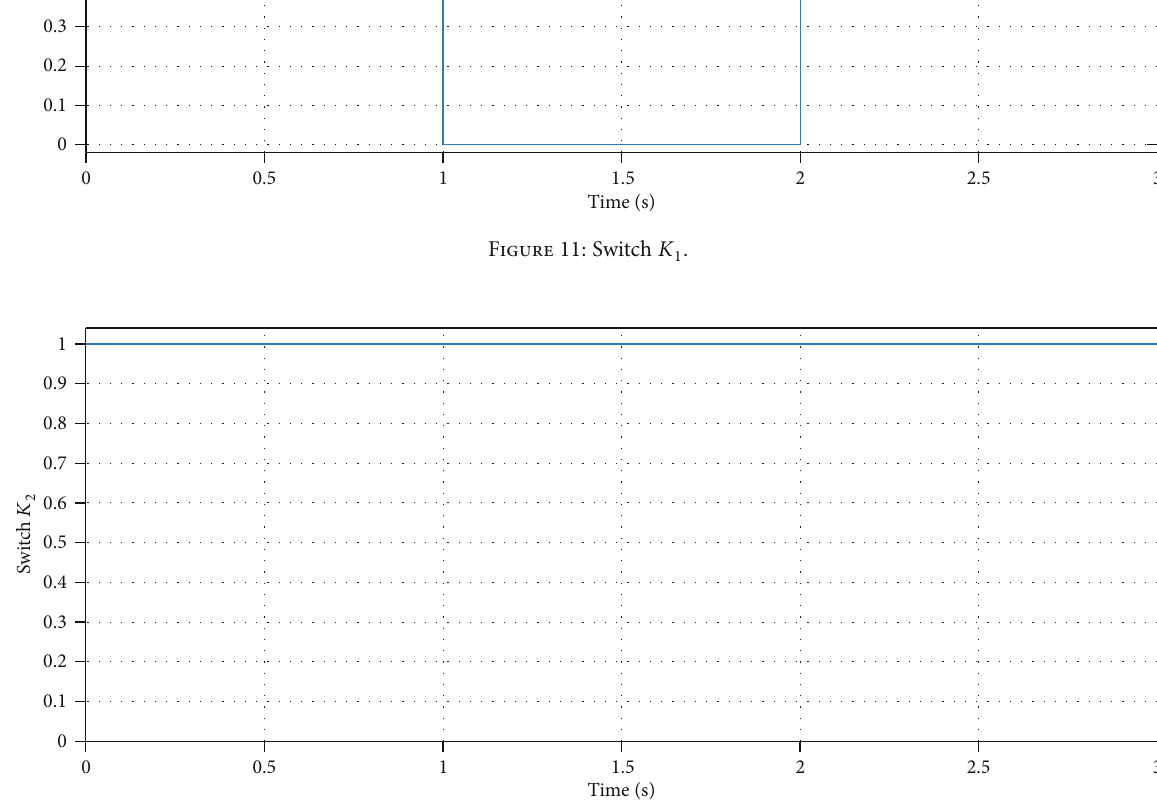
Figure 12: Switch K